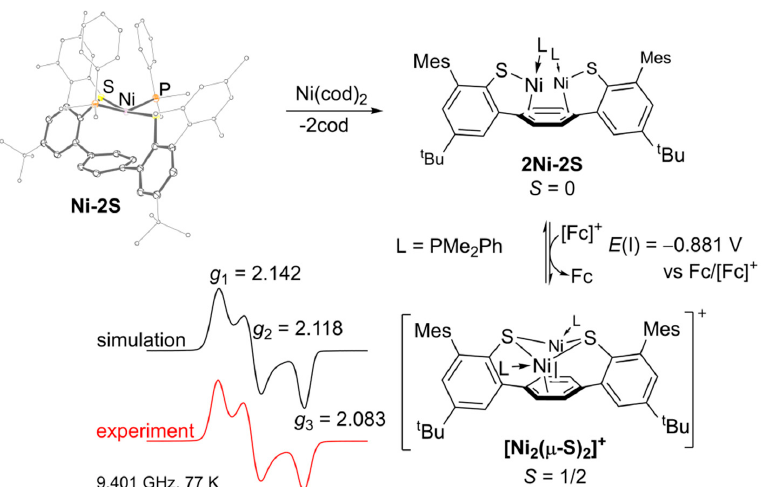
Figure 2. Preparation, molecular structures, and selected properties of mono- and bimetallic complexes of nickel; N(SO 2 CF 3 ) 2 counteranion of [Ni 2 (µ-S) 2 ] + and H-atoms in ORTEP representation of Ni–2S omitted for clarity; X-Band cw-EPR spectrum recorded from 2-methyltetrahydrofuran glass at 77 K, g -factors determined by digital simulation; Fc = ferrocene, and cod = 1,5-cyclooctadiene. Single crystal X-ray diffraction (XRD) analysis confirmed the skeletal connectivity of [Ni 2 (µ-S) 2 ] + as drawn in Figure 2. Despite moderate resolution of diffraction data impaired structure refinement to a high level of accuracy, PMe 2 Ph ligated [Ni 2 (µ-S) 2 ] + is isostructural to its PMe 3 congener [24]; pertinent data are provided in the supplementary material. Short Ni–C distances of ~2.01 Å point to a η 2 : η 2 -coordination of the 1,4-disubstituted π -system to the nickel atoms. Coordination of two thiophenolates in µ-fashion in addition to the PMe 2 Ph coligand completes a distorted tetrahedral ligand environment at each nickel atom. Acute Ni–(µ-S)–Ni bond angles of ~63° render the Ni–Ni